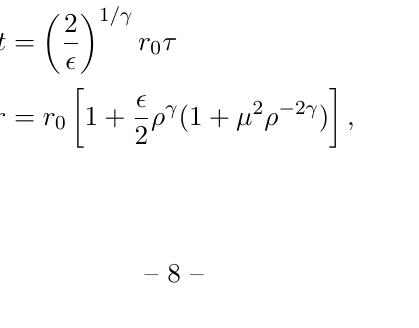
Figure 2 . Characterization of the q -deformed charged, dilatonic geometry of eq. (2.15) in terms of mass M , magnetic charge P , and dilatonic charge D defined in eq. (3.2). In this plot, λ = as one obtains under Kaluza-Klein reduction of five-dimensional gravity on a circle, and we have plotted the surfaces occupied by spacetimes for q = 1 / 2 (orange), q = 1 (green, GHS), q = 3 / 2 √ (blue), and the maximal value of q = 1 + λ 2 = 2 (purple). The region forbidden by the extremality bound in eq. (3.5) is shown in gray, and the q -independent universal extremal solution of eq. (2.19) is given by the yellow